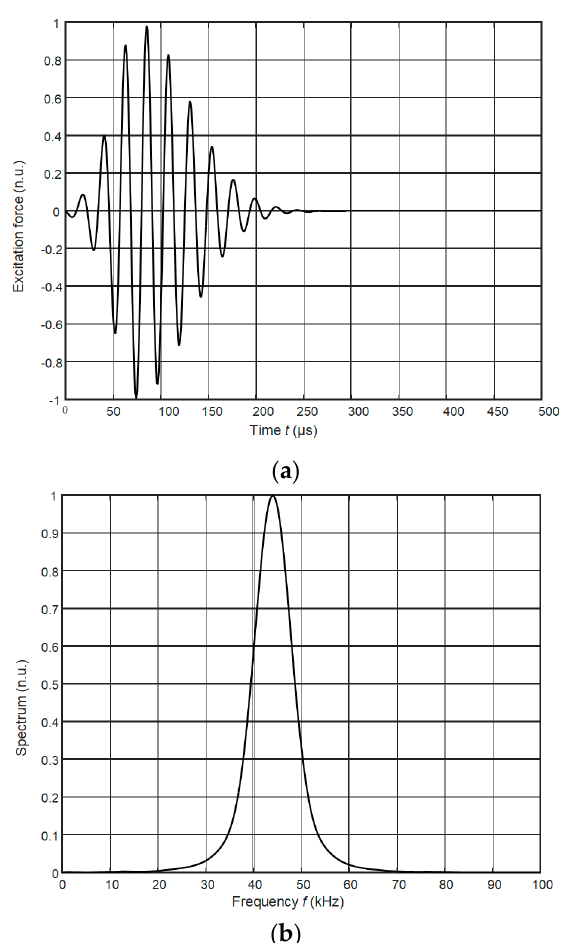
Figure 2. The waveform ( a ) and the spectrum of the excitation force ( b ); n.u. represents normalized